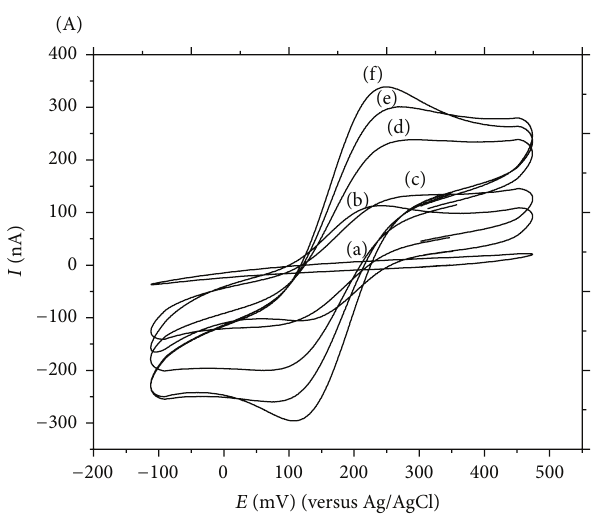
Figure 5: Electrochemical data for FOSC action on supported lipid bilayer membrane as a function of fructan concentration. Cyclic voltammetric response of 1.0mmol/L K 3 [Fe(CN) 6 ]/K 4 [Fe(CN) 6 ] (1:1) solution containing 0.1 mol/L KCl, at Pt-s-BLM after interac- tion with different concentrations of FOSC for 20 min: (a) 0.0, (b) 2.5, (c) 5.0, (d) 7.5, (e) 10.0, and (f) 12.5 g/L. Scan rate 50 mV ⋅ s −1 .